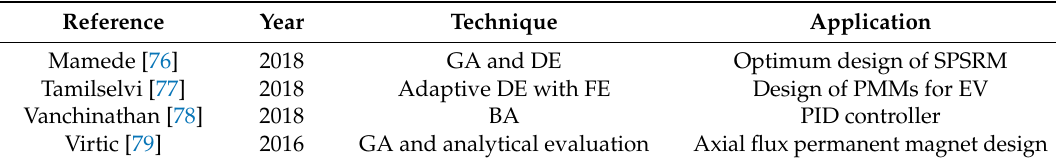
Table 5. Evolutionary computing and